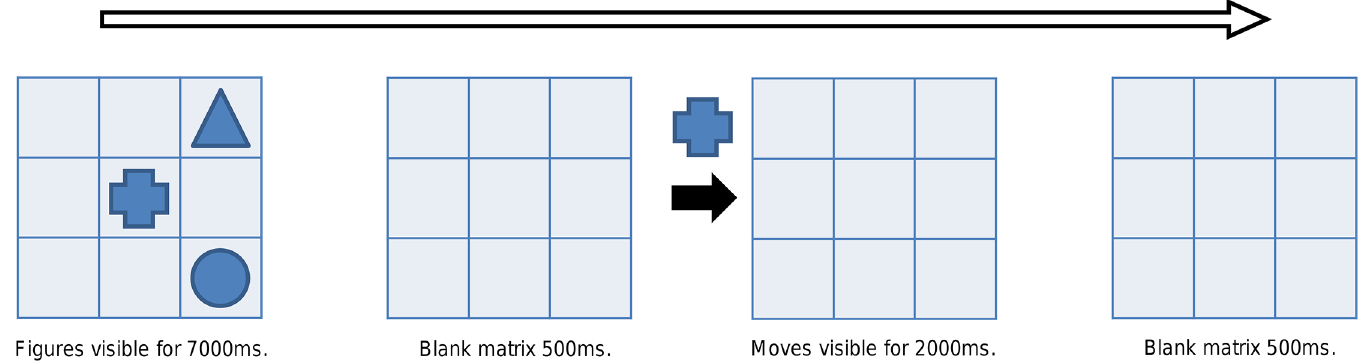
Fig 3. Example of a Moving Figures task with three figures. Only one move is shown in this example while an actual sequence consisted of several turns, each consisting of one to three moves.